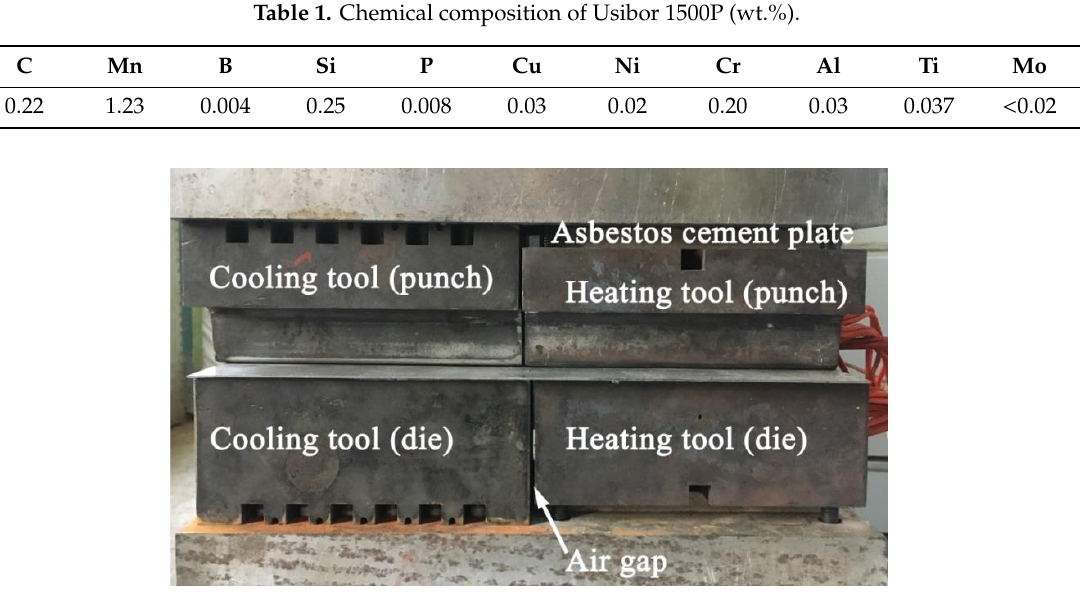
Table 1. Chemical composition of Usibor 1500P (wt.%).